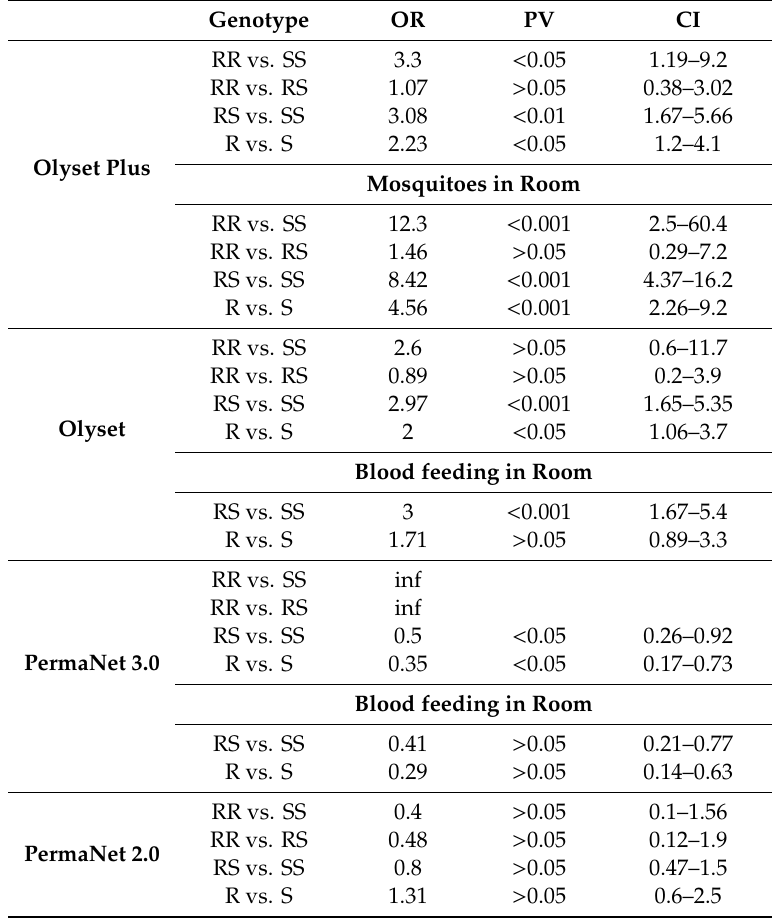
Table 5. Impact of L119F- GSTe2 mutation on the e ffi cacy of various bed nets to prevent blood